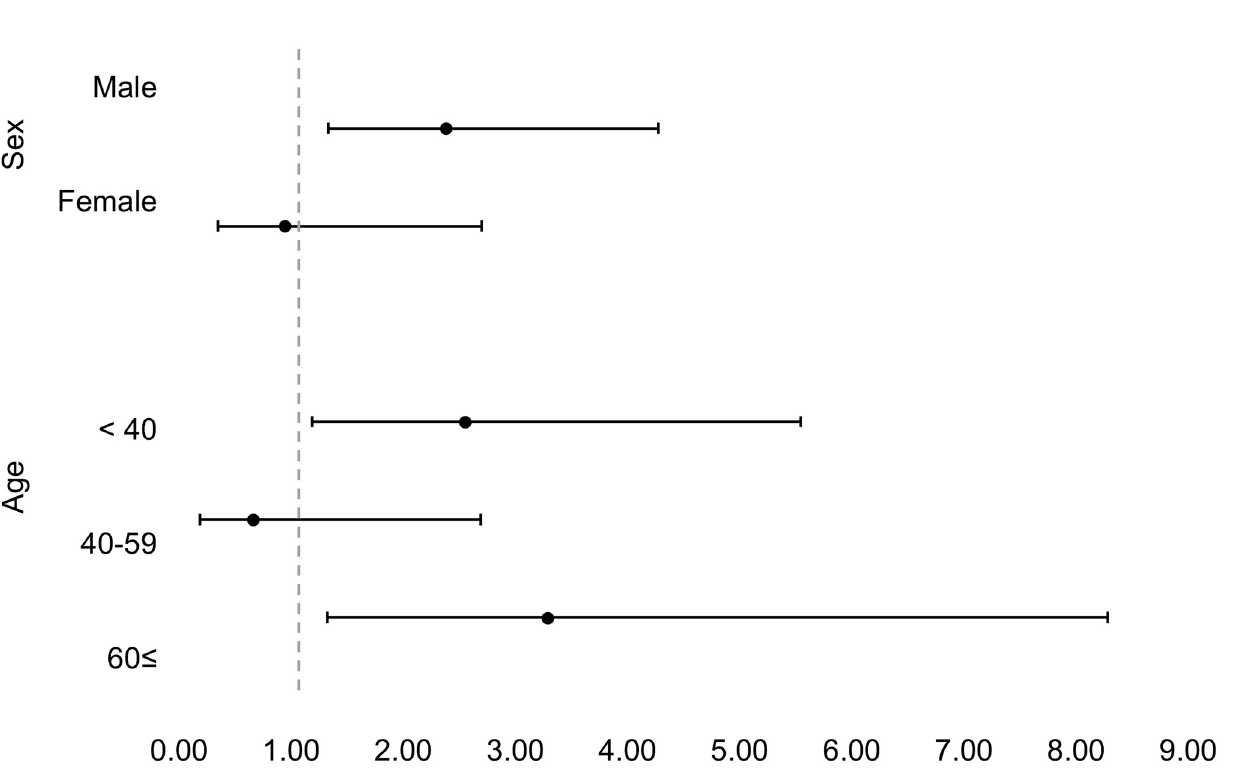
Fig 3. Results of subgroup analysis for association between TB recurrence and BMI, stratified by sex and age among subjects with health exam data (BMI < 18.5 vs 18.5 � ). (Abbreviation: BMI, Body Mass Index, TB, tuberculosis).